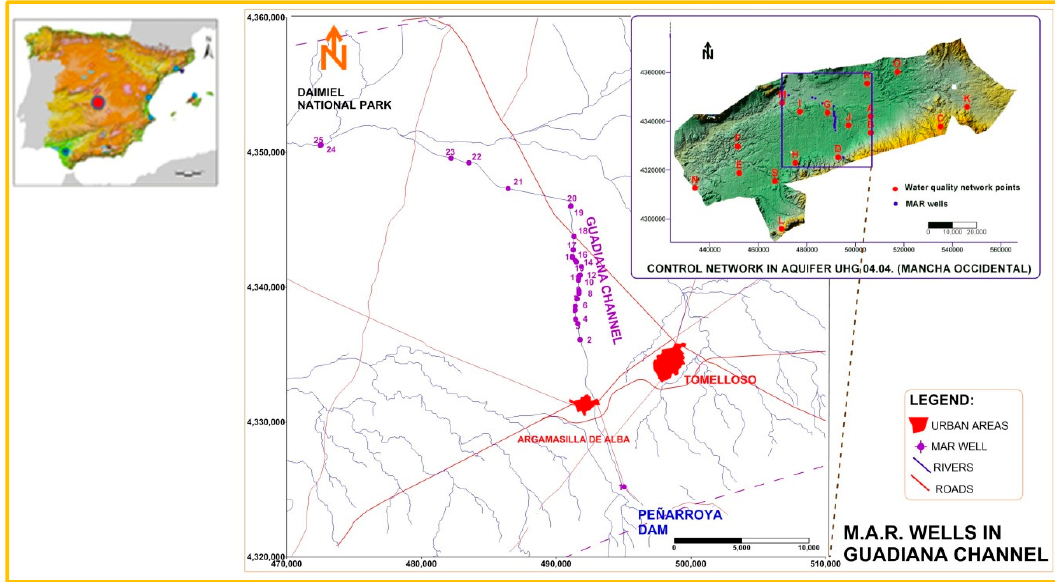
Figure 3. General sketch of the MAR system of wells near Canal del Guadiana for irrigation and environmental